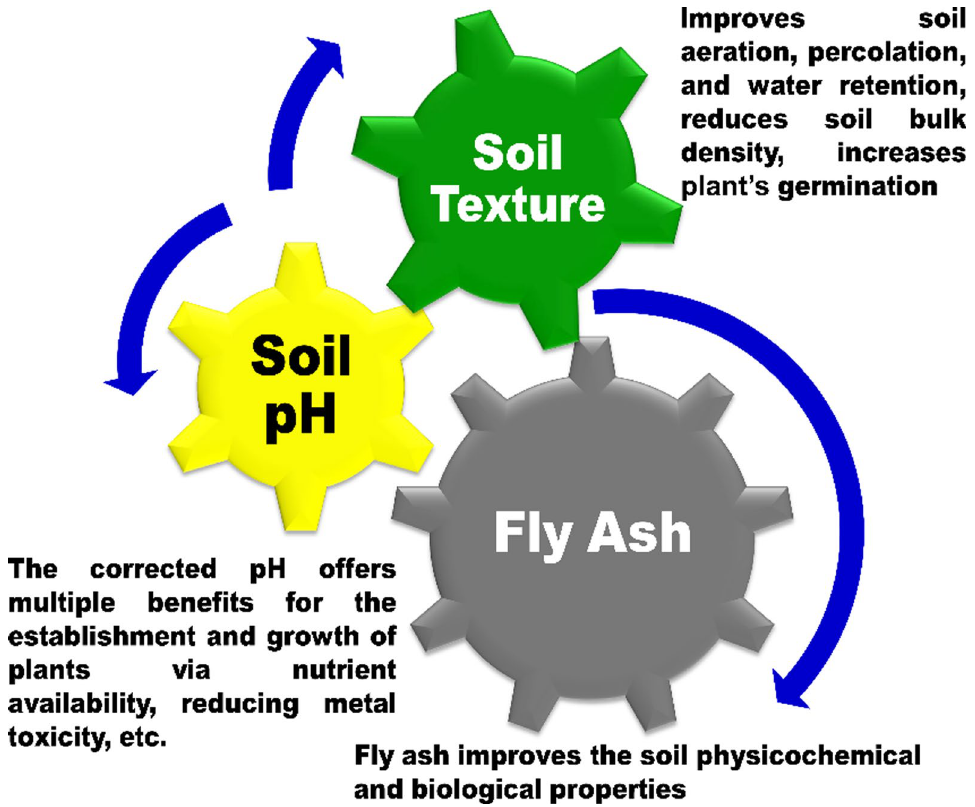
Fig. 3 Role of CFA in improving soil